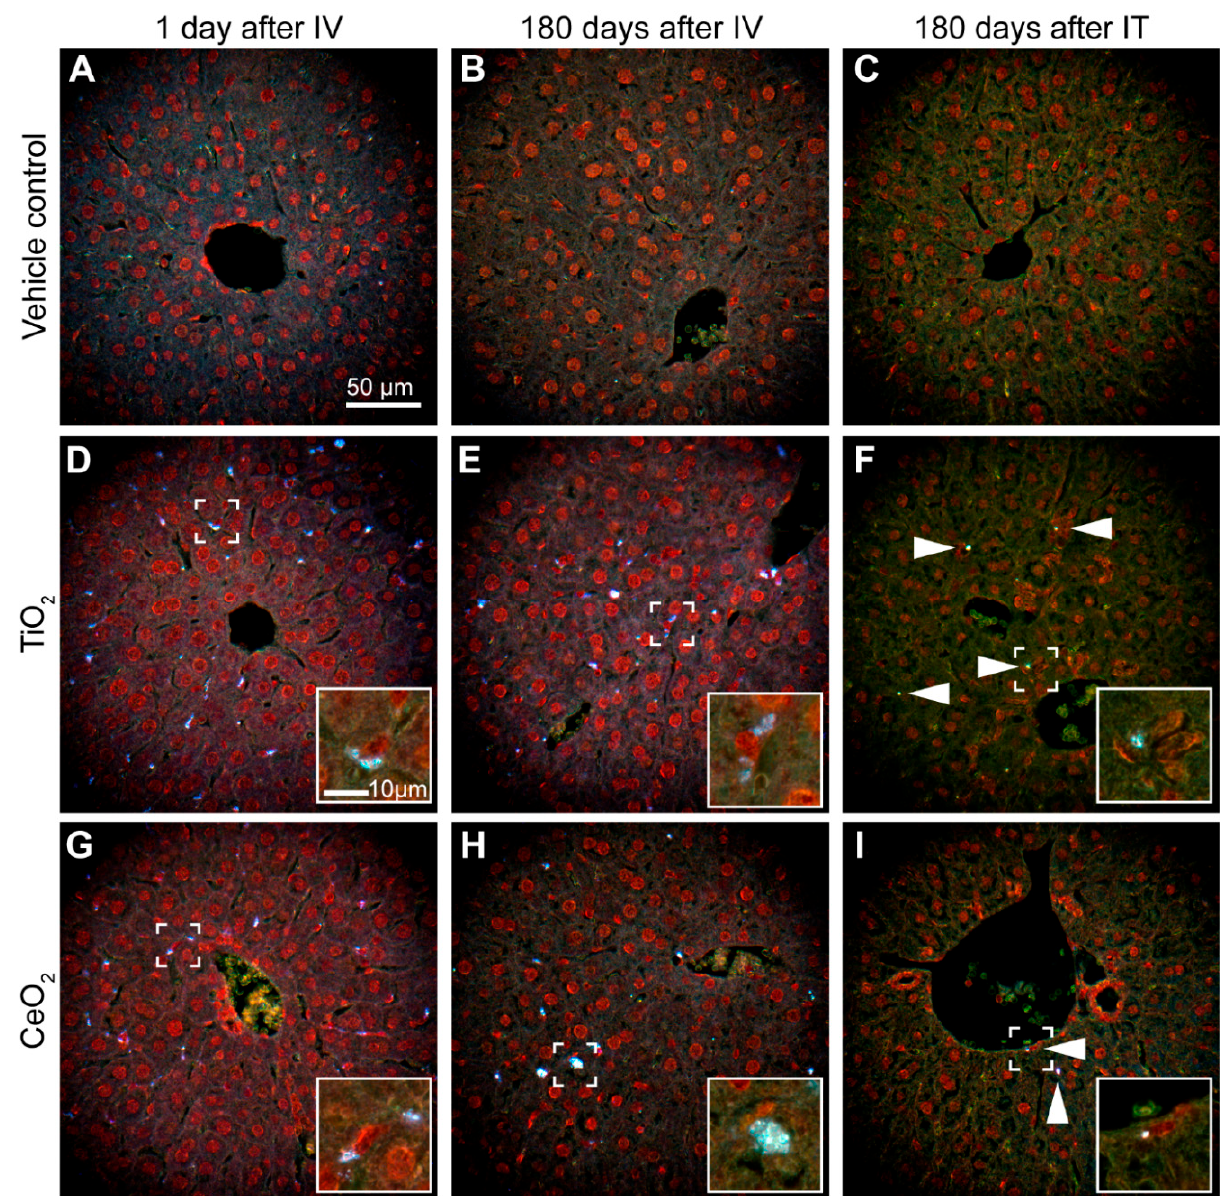
Figure 1. Liver tissue 1 and 180 days after intravenous (IV) or intratracheal (IT) exposure to vehicle control ( A – C ), TiO 2 ( D – F ) and CeO 2 ( G – I ) nanoparticles. Enhanced darkfield microscopy. ( D , G ): Agglomerates of foreign material (white) were distributed across liver sections 1 day after intravenous exposure and often appeared phagocytized by Kupffer cells (inserts in ( D , G )). ( E , H ): 180 days after intravenous exposure, material was accumulated in fewer and larger agglomerates. ( F , I ): Agglomerates seen 180 days after intratracheal instillation were small and much less frequent (arrowheads). Scale bars in A and in the insert in D apply to all